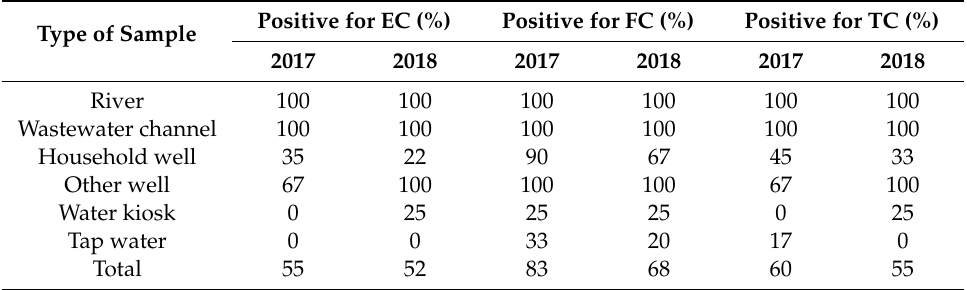
Table 3. The fraction of samples with detection of total / fecal coliforms and E. coli for di ff erent sample